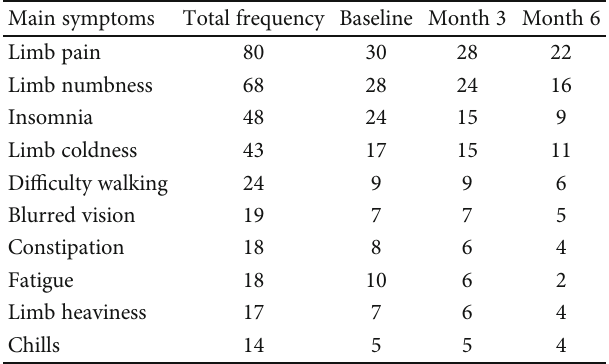
Figure 1: Change in the frequency of neuropathic pain. After 3 months of modi fi ed HGWD, 2 patients recovered from moderate neuropathic pain, 8 patients turned from moderate to mild neuropathic pain, and 2 turned from severe to moderate neuropathic pain, while 18 patients (12 with moderate and 6 with severe pain) remained unchanged. After 6 months, 8 patients recovered from moderate neuropathic pain, 10 patients turned from moderate to mild neuropathic pain, 1 patient turned from severe to mild neuropathic pain, and 6 patients with severe pain turned to moderate pain, while only 5 patients remained unchanged. Table 5: Frequency of common